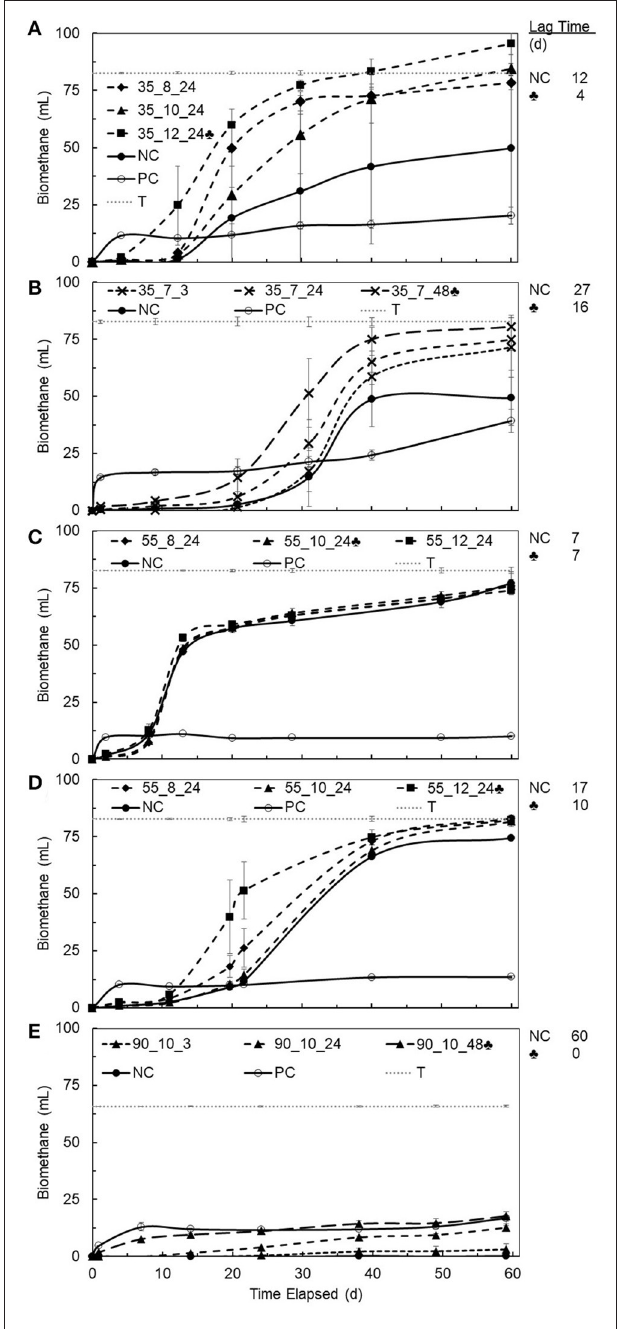
FIGURE 3 | Average cumulative biomethane produced during BMP assays ( n = 3, error bars and one standard deviation, 35 ◦ C, ambient pressure) vs. time elapsed for PHB1 (A), PHB2 (B) , PHB3 (C) , PHB4 (D) , PLA (E) after pretreatment. Conditions of pretreatment are denoted on each chart as temperature, ◦ C _ pH _ incubation time, h. Dashed lines show incubation times and pH 7 ( x ), pH 8 ( (cid:7) ), pH 10 ( N ), pH 12 ( (cid:4) ), and highest biomethane production ( ♣ ). Solid lines show controls; negative control (NC •) was untreated bioplastic, positive control (PC ◦ ) was glucose, dotted line denotes theoretical maximum (T) biomethane production, and lag time shown to the right of each